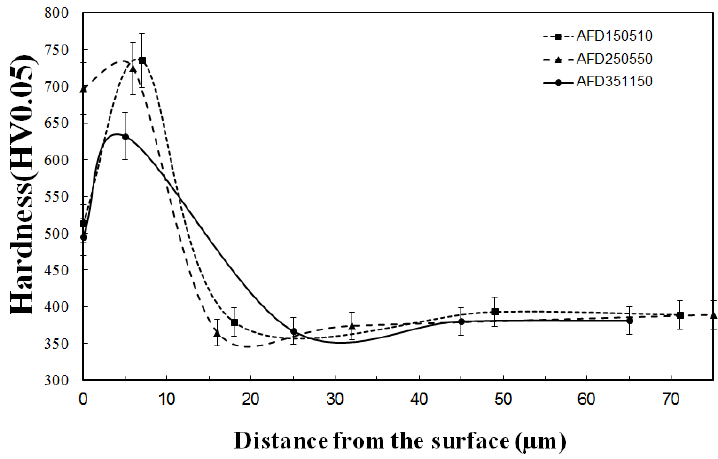
Figure 13. Hardness profile from surface to depth for samples AFD150510, AFD351150 and AFD250550.